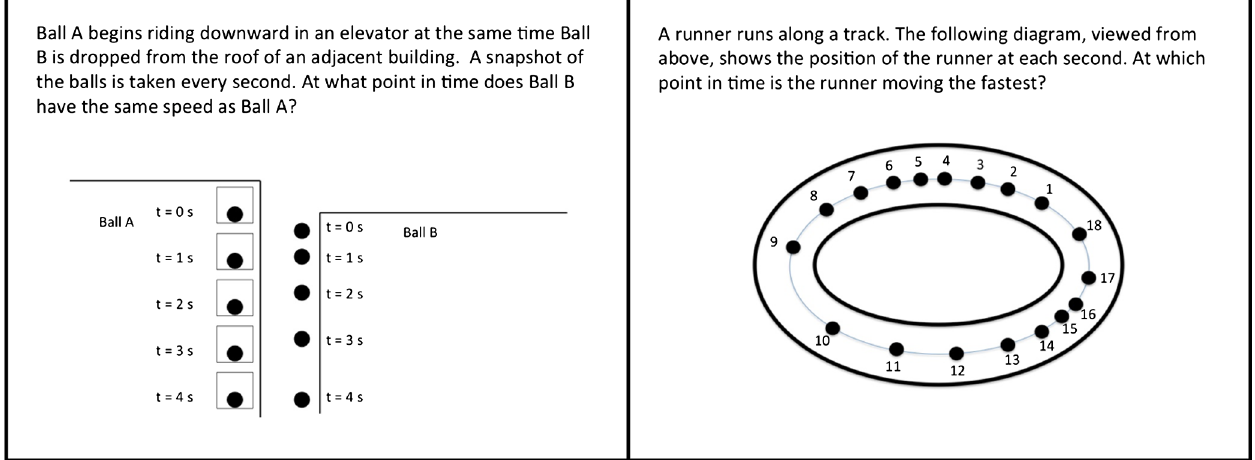
FIG. 2. Example near (left) and far (right) transfer problems (definition of